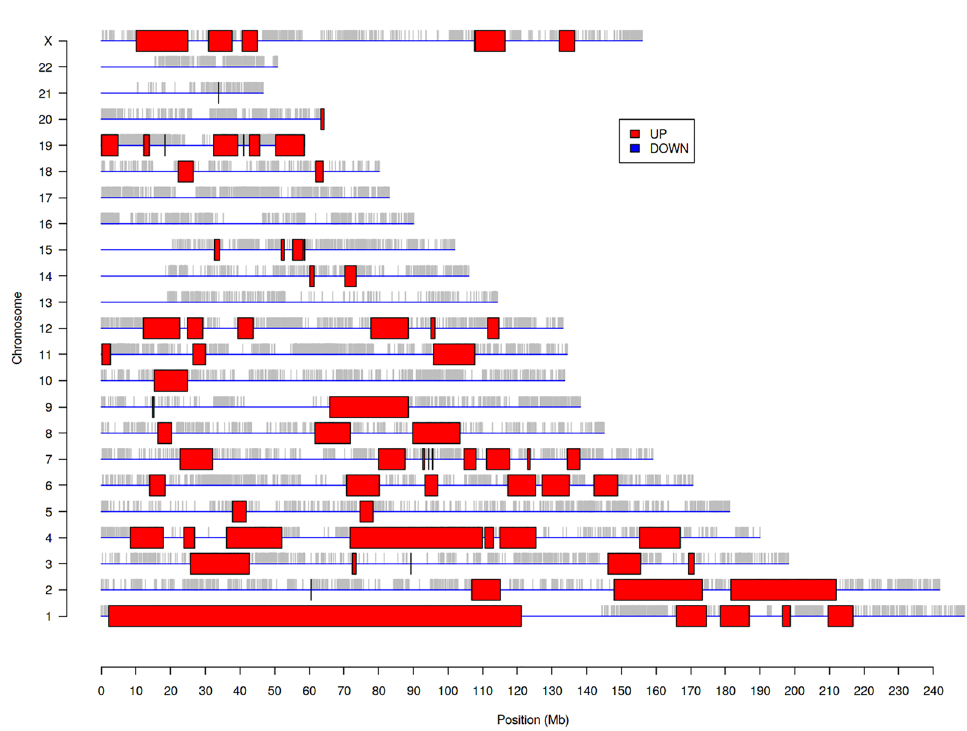
Figure 3. Genomic regions significantly dysregulated in WHO grade II LGG cases with high vs low DMD expression. Significantly altered regions are highlighted with coloured